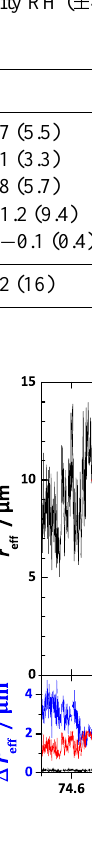
Fig. 6. Top panel: cloud optical thickness τ in aircraft nadir re- trieved from the SMART-Albedometer radiance by 2WL. Bottom panel: relative difference 1τ between τ retrieved by 2WL and 5WL (blue); propagated uncertainty u(τ) in 5WL (black) and 2WL (red), in percent.